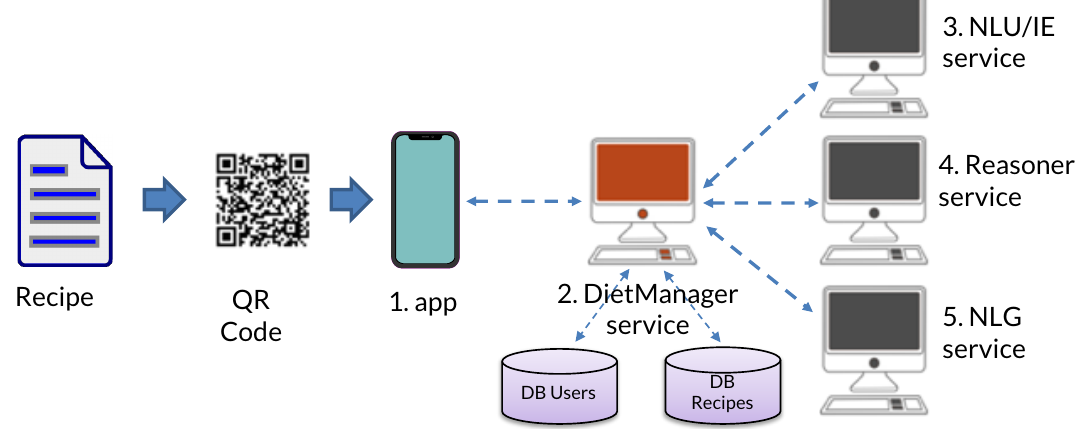
Figure 1. The schema of the Multimedia Application for Diet Management (MADiMan) architecture. NLG, natural language